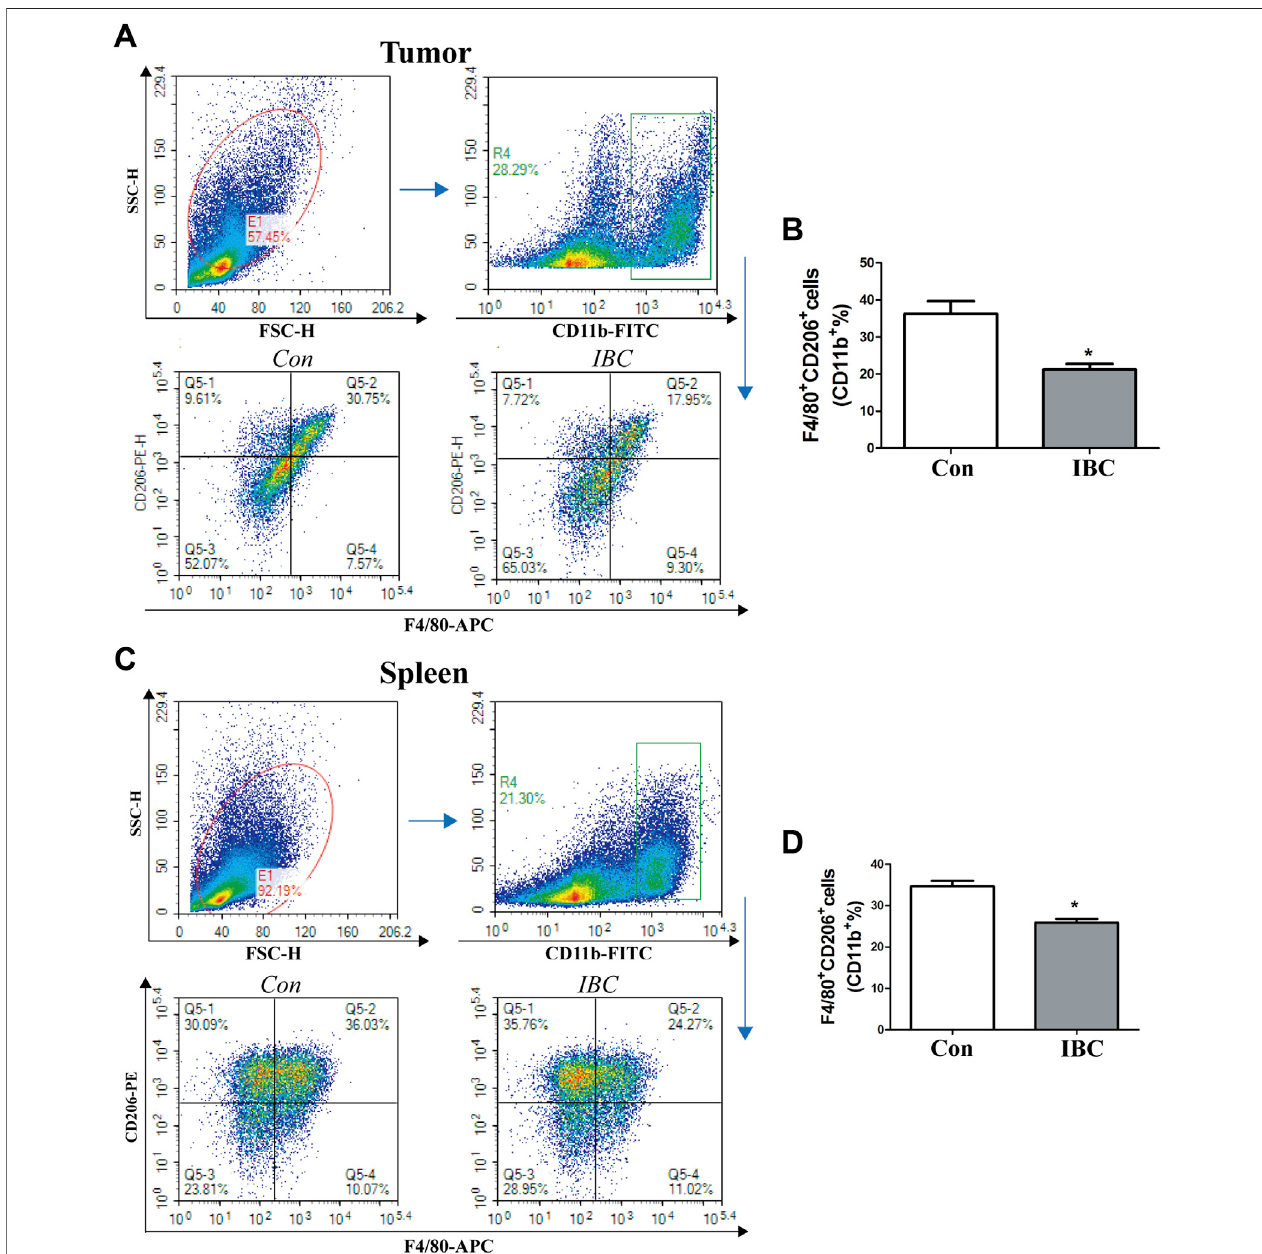
FIGURE 9 | Effects of IBC on M2-like macrophage polarization. (A,B) M2 macrophages polarized in the tumor tissue ( N = 5), * p < 0.05 versus the control. (C,D) M2 macrophages polarized in the spleen ( N = 5), * p < 0.05 versus the control.